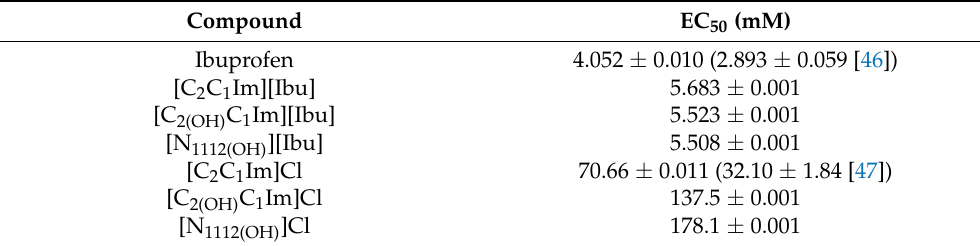
Table 5. EC 50 values of ibuprofen, ibuprofen-based ILs and IL/salt cation “suppliers” for the